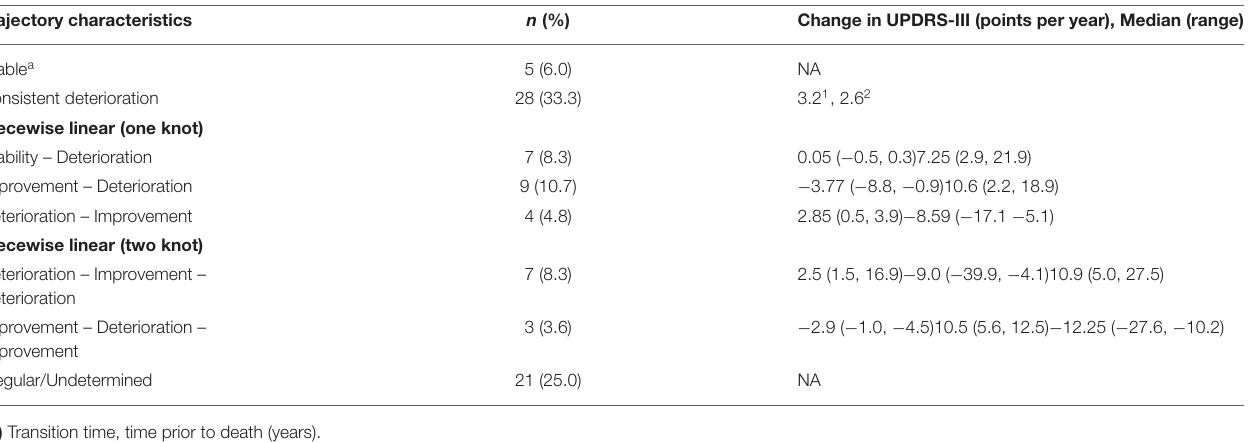
TABLE 2 | Trajectory characteristics of the Parkinson patients (time prior to death, n = 84). (A) Change in